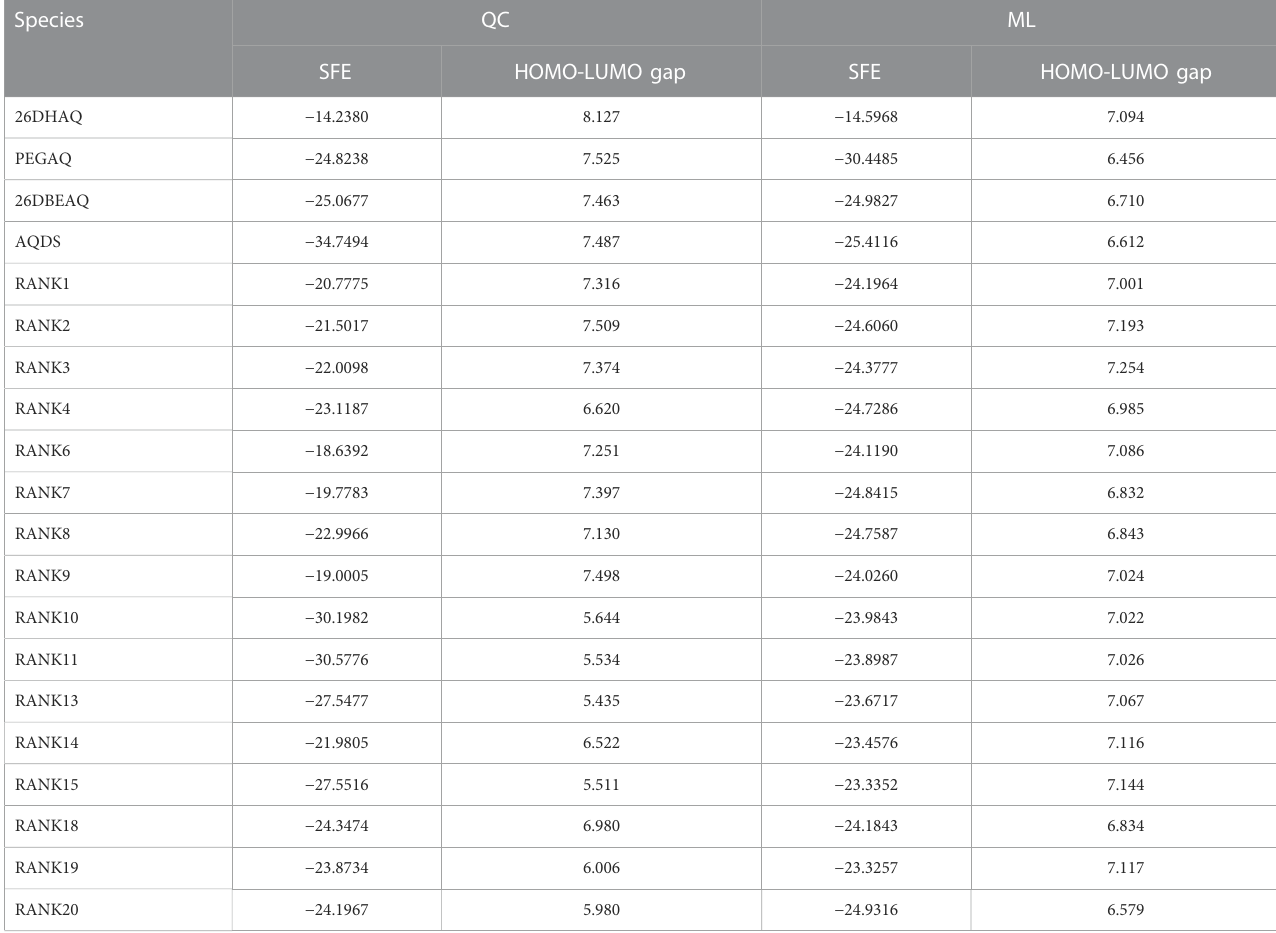
TABLE 3 Comparison of quantitative calculation results with ML predicted results.